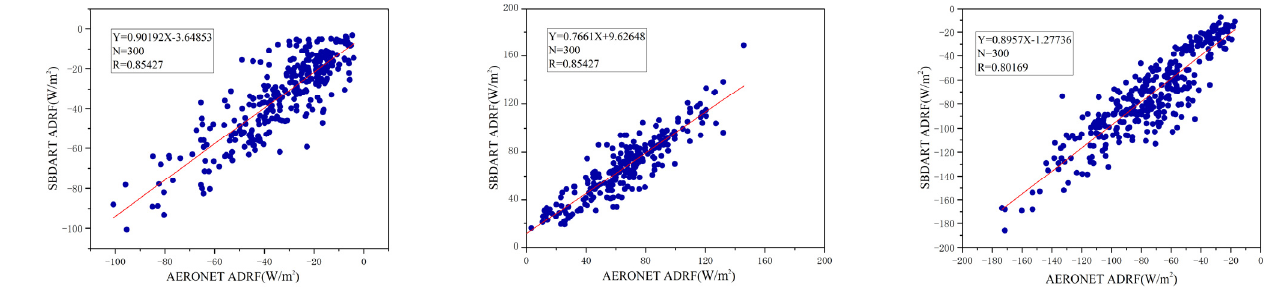
Figure 5. Verification of SBDART ADRF and AERONET ADRF at TOA, ATM and BOA.